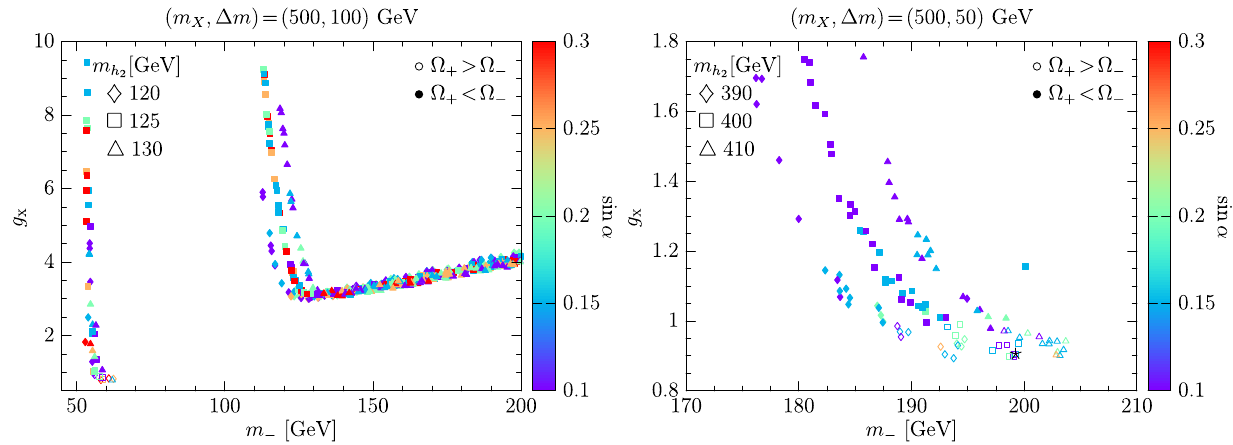
Fig. 8 The plots show results of scans over the parameter space of a 2CDM case, for which ψ + and ψ − are stable. All the points satisfy the correct relic density observed by PLANCK at 5 σ and the recent direct